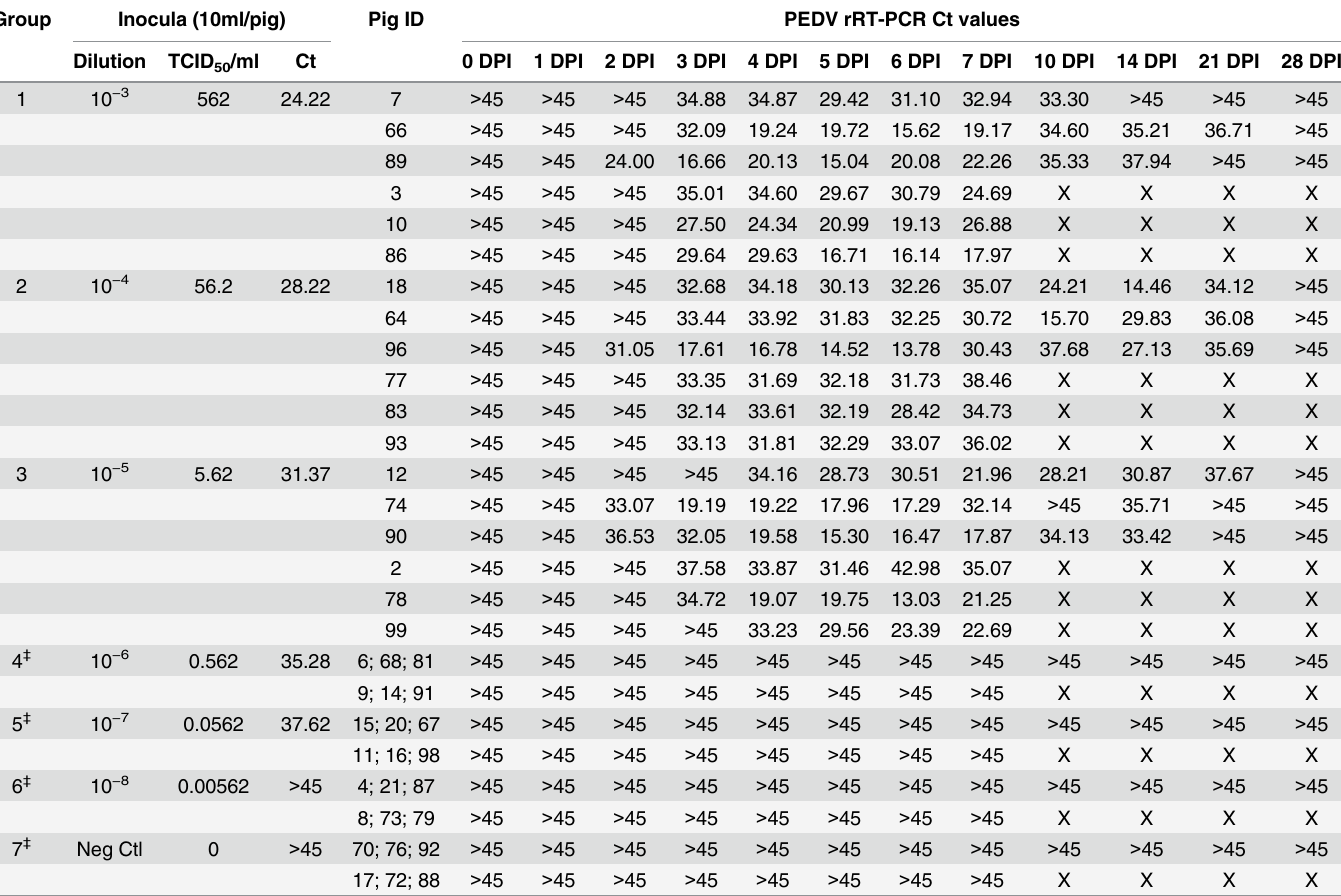
Table 5. PEDV shedding in rectal swabs of the weaned pigs. * Group Inocula (10ml/pig) Pig ID Dilution TCID 50